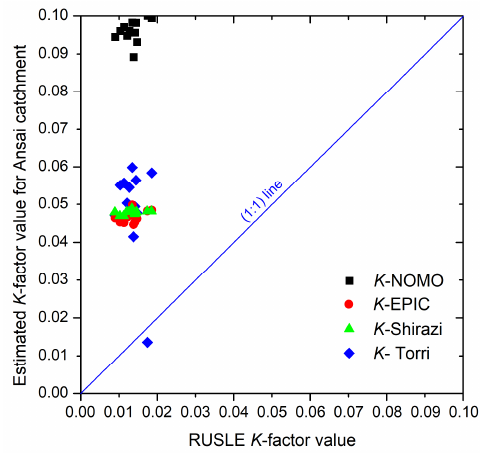
Figure 2. The comparison of the RUSLE and other estimated K values for 12 RUSLE soils at catchment scale (unit: t·hm 2 ·h/(MJ·mm·hm 2 )).